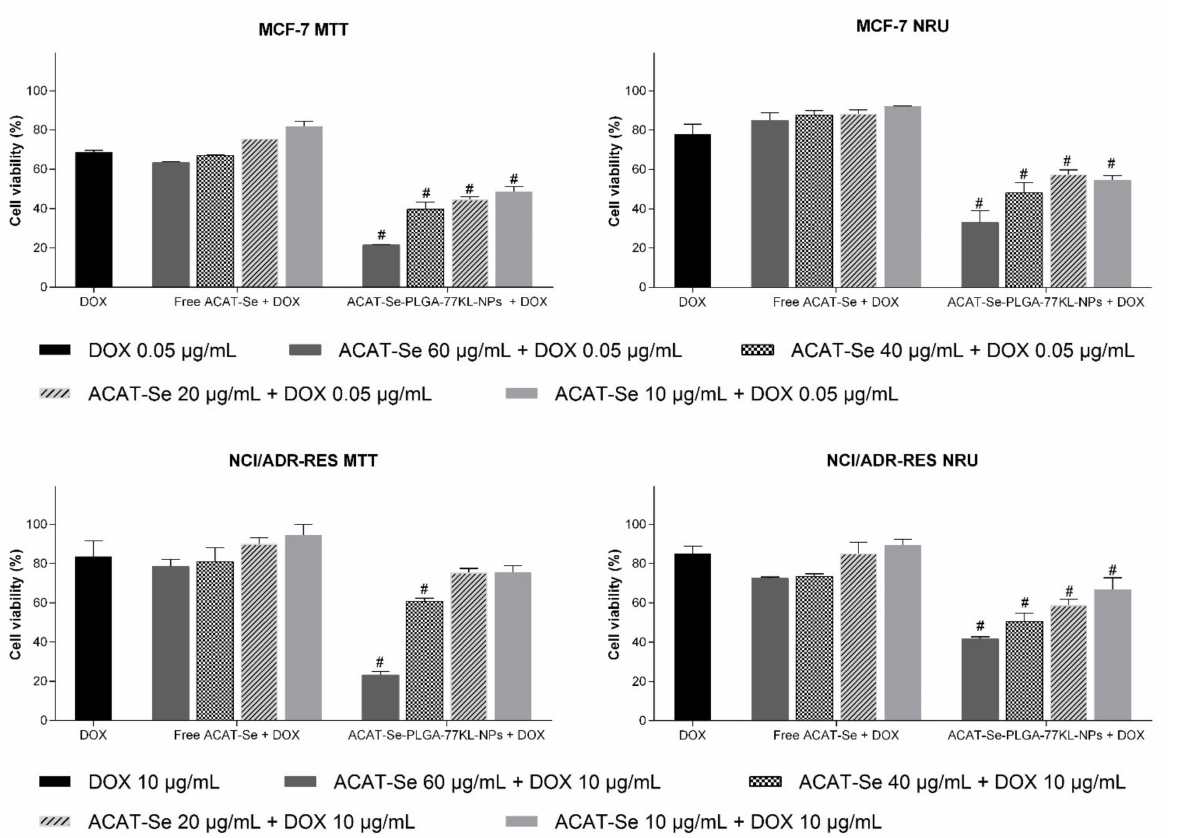
Figure 8. In vitro cell viability as detected by MTT and NRU assays after 72 h coincubation of free or nanoencapsulated ACAT-Se with DOX in MCF-7 and NCI/ADR-Res cell lines. Data are expressed as mean of three independent experiments ± SE. Statistical analyses were performed using ANOVA followed by Student–Newman–Keuls multiple comparison test. # Significant difference from free ACAT-Se + DOX ( p < 0.05).